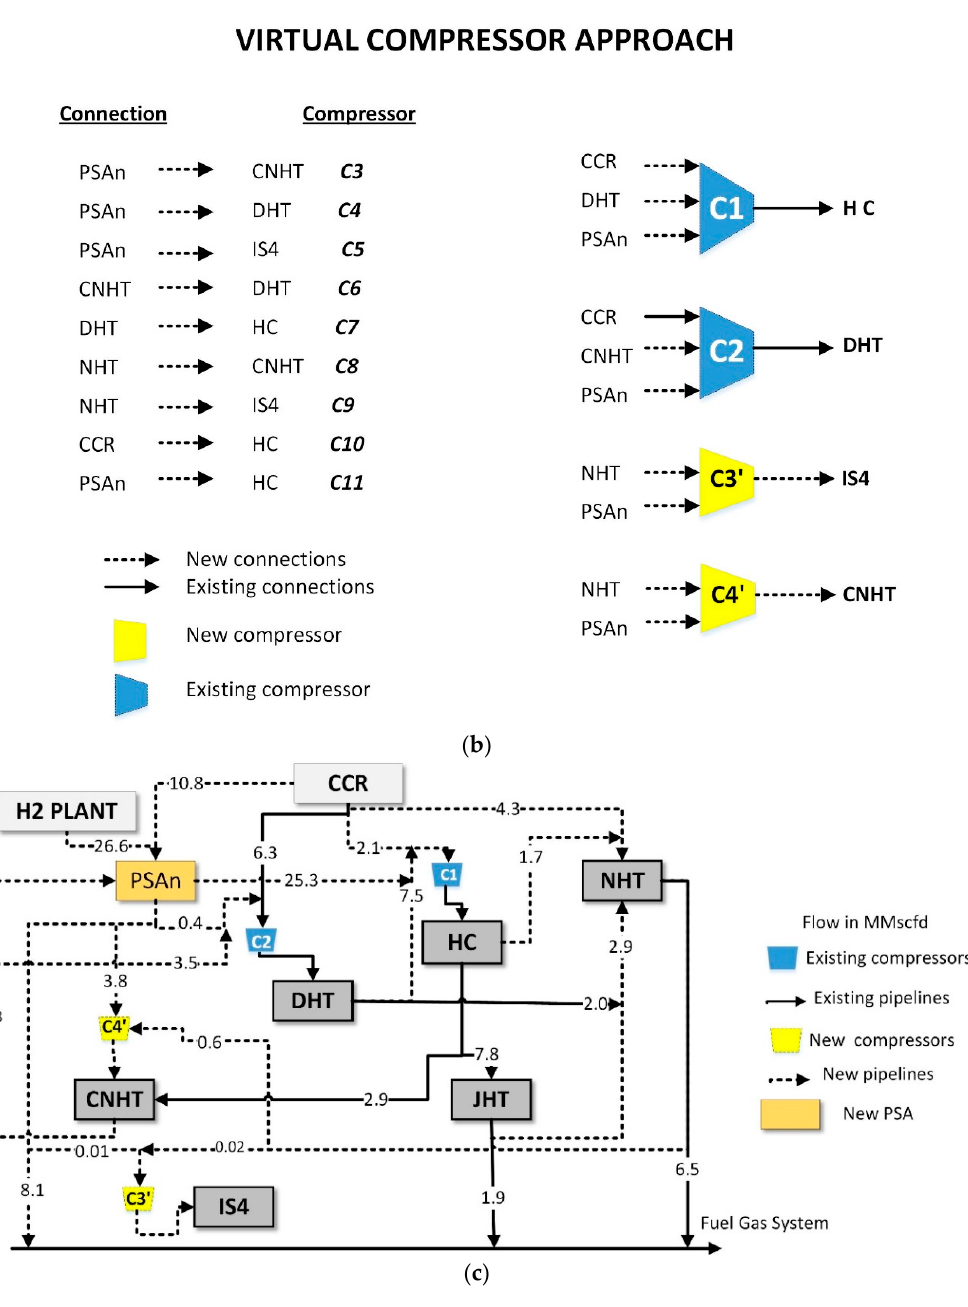
Figure 5. ( a ) Optimized network HN1 via HNS LM, for Example 1. ( b ) Virtual compressor approach applied to HN1 network. ( c ) Optimized network HN1’ with rearranged compressors.